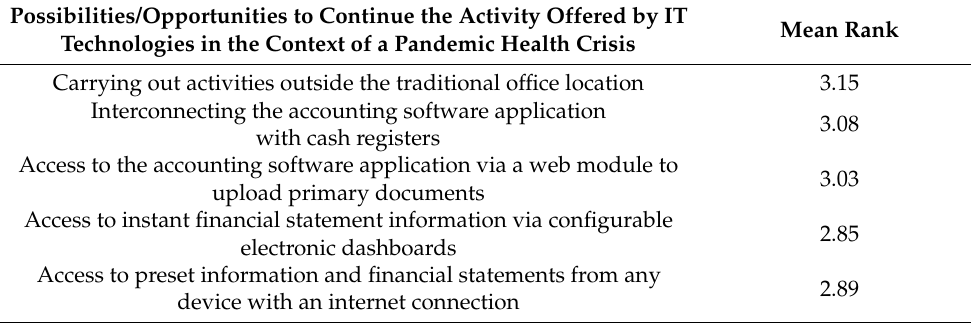
Table 12. Hierarchy of possibilities/opportunities to continue the